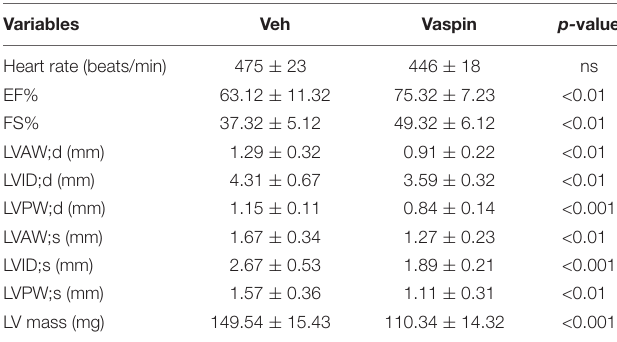
TABLE 1 | Echocardiography analysis of mice treated with vaspin or control vehicle.